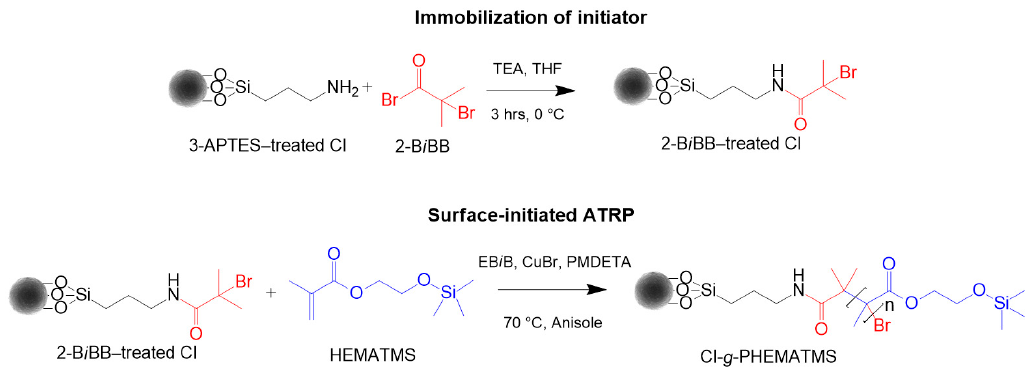
Figure 1. Preparation scheme of the CI- g -PHEMATMS via SI-ATRP. Table 1. Reaction stoichiometry and experimental conditions for SI-ATRP of PHEMATMS grafts